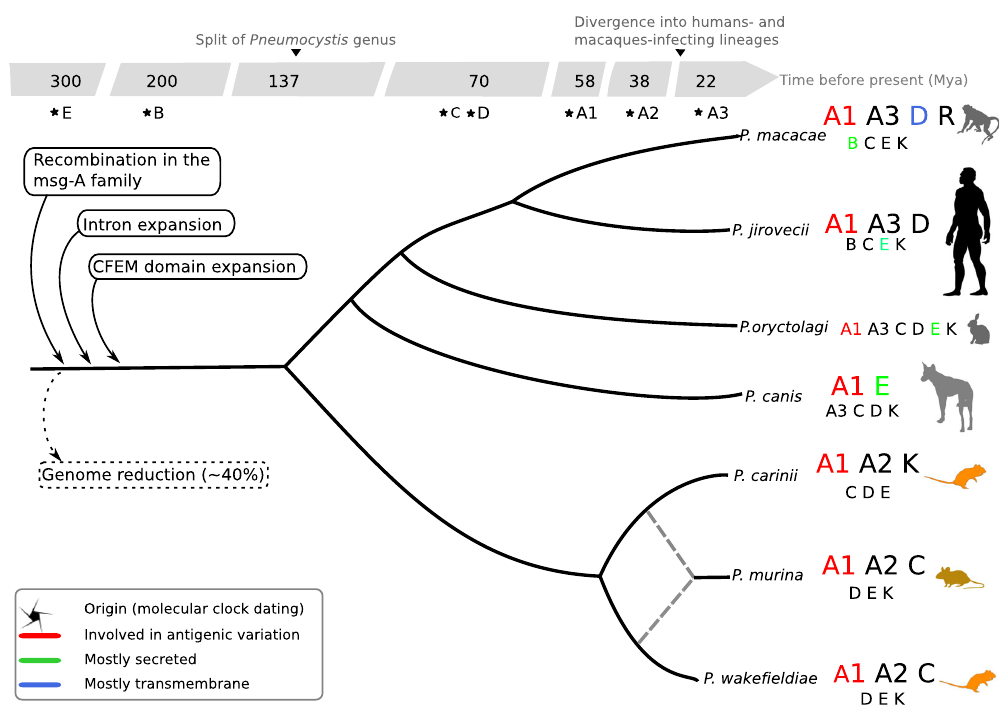
Fig. 6 Overview of the genomic evolution of the Pneumocystis genus. Gene families are represented by letters: A to E for the fi ve families of major surface glycoproteins (Msg) with the A family being further subdivided into three subfamilies A1, A2, and A3; K and R for kexins and arginine-glycine rich proteins, respectively. Larger fonts indicate expansions as inferred by maximum likelihood phylogenetic trees and networks. Dashed lines represent ancient hybridization between P. carinii and P. wake fi eldiae . Detailed analysis also reveals distinct phylogenetic clusters within subfamilies. Introns and CFEM (common in fungal extracellular membrane) domains are enriched in Pneumocystis genes which indicate that these elements were likely present in the most recent common ancestor of Pneumocystis species. Animal icons were obtained from http://phylopic.org under creative commons licenses https:// Keesey; license CC BY 3.0), rabbit (by Anthony Caravaggi; license CC BY-NC-SA 3.0), and rat (by Rebecca Groom; license CC BY-NC-SA 3.0). Icons original black color background were modi fi ed to gray and orange